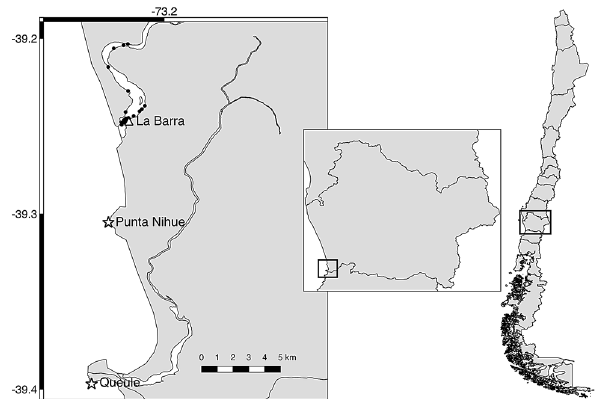
Figure 1. Map of the study area showing the location of the 33 hauls onboard artisanal fishing boats and the location of the two South American sea lion colonies close the area: Punta Nihue and Queule. Figures were done by QGIS software version 2.18 (http:// www. qgis.